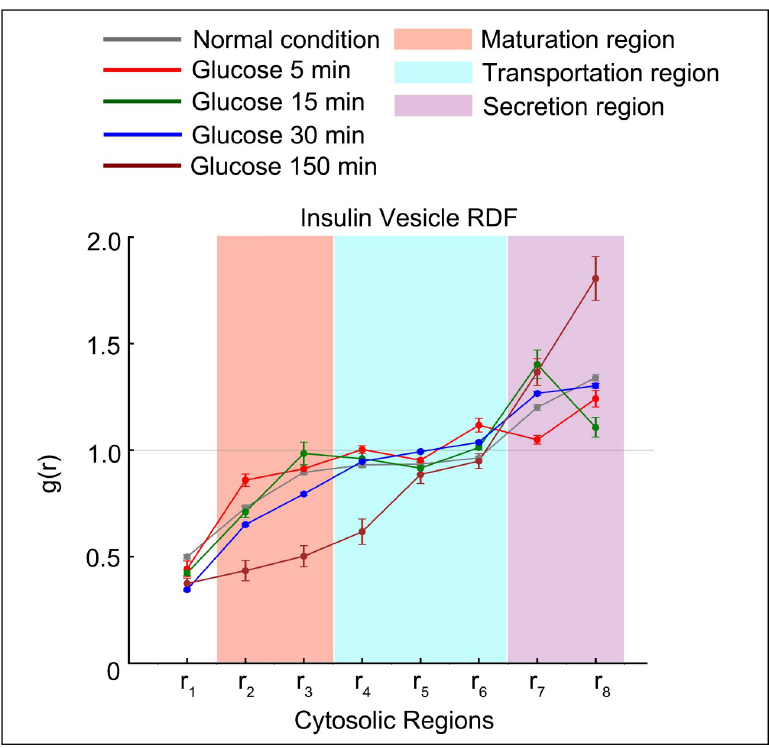
Fig 3. Insulin vesicle distribution and functional regions related to the insulin secretion pathway. Radial distribution function (RDF) of insulin vesicles from the nuclear membrane under the given treatment conditions. Functional spaces related to the insulin secretion pathway are shown with different background colors as indicated. The light gray horizontal line at g ( r ) = 1.0 shows where the probability of finding insulin vesicles in a shell is the same as random